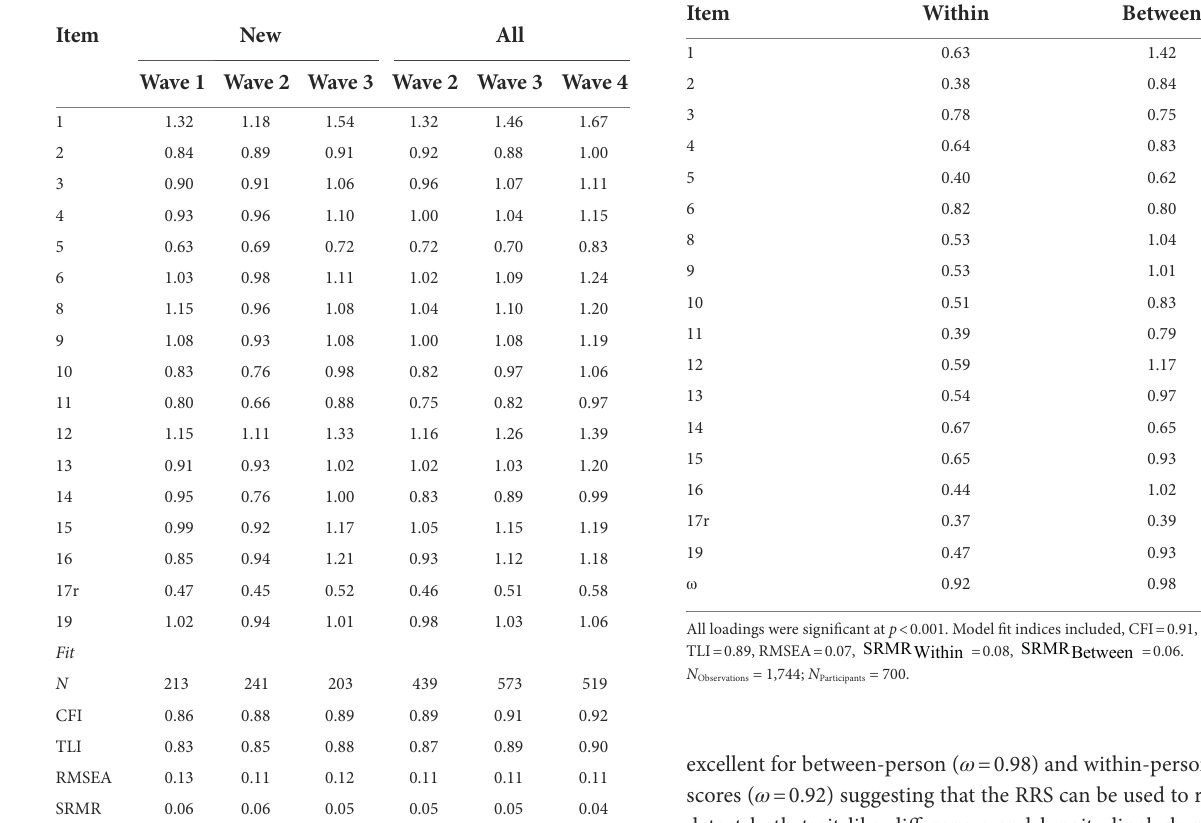
TABLE 4 Multilevel factor loadings and